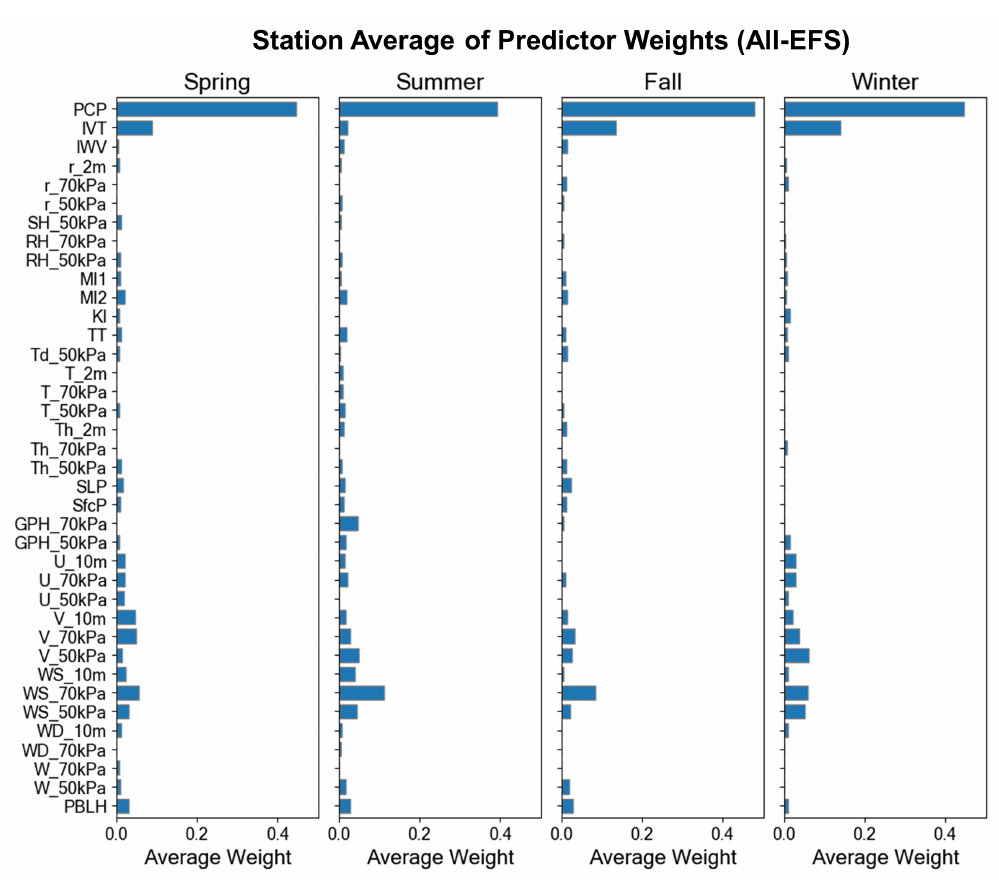
Figure A3. Station average of the final predictor weights resulting from the All-EFS method (see Section 2.2.1) for each season. Variables that are in Table 1 but not in the x-axis were never selected by any station at any